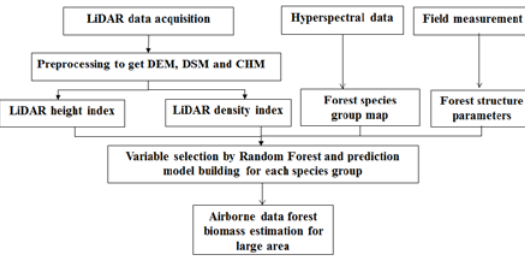
Figure 1. Workflow of forest biomass estimation by fusion of airborne lidar and hyperspectral data